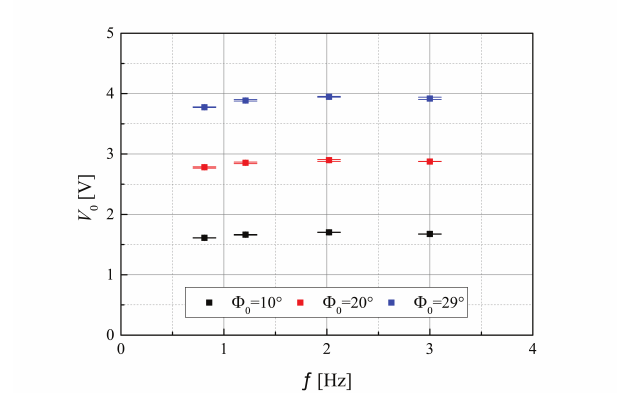
Figure 8. Peak-to-peak voltage of the smart textile according to the operating frequency. The maximum, minimum, and averaged peak-to-peak voltages of the repetitive experiments are represented as error bars. The black, red, and blue squares represent the peak-to-peak voltages according to the operating frequency at Φ of 10°, 20°, and 29°,